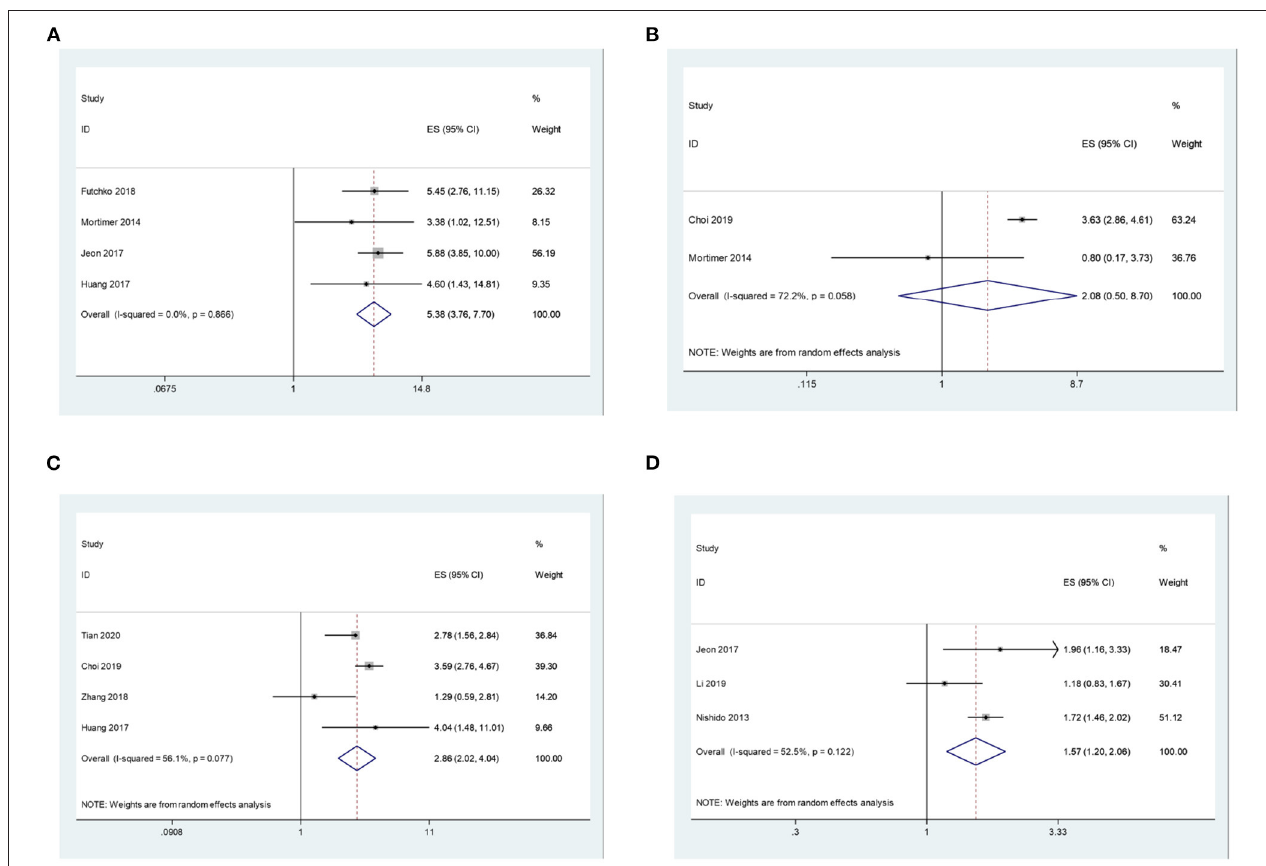
FIGURE 3 | (A) The correlation between aneurysms of size > 7mm and recurrence after coil embolization for intracranial aneurysms. (B) The correlation between aneurysms of neck > 4mm and recurrence after coil embolization for intracranial aneurysms. (C) The correlation between ruptured aneurysm and recurrence after coil embolization for intracranial aneurysms. (D) The correlation between SAH and recurrence after coil embolization for intracranial